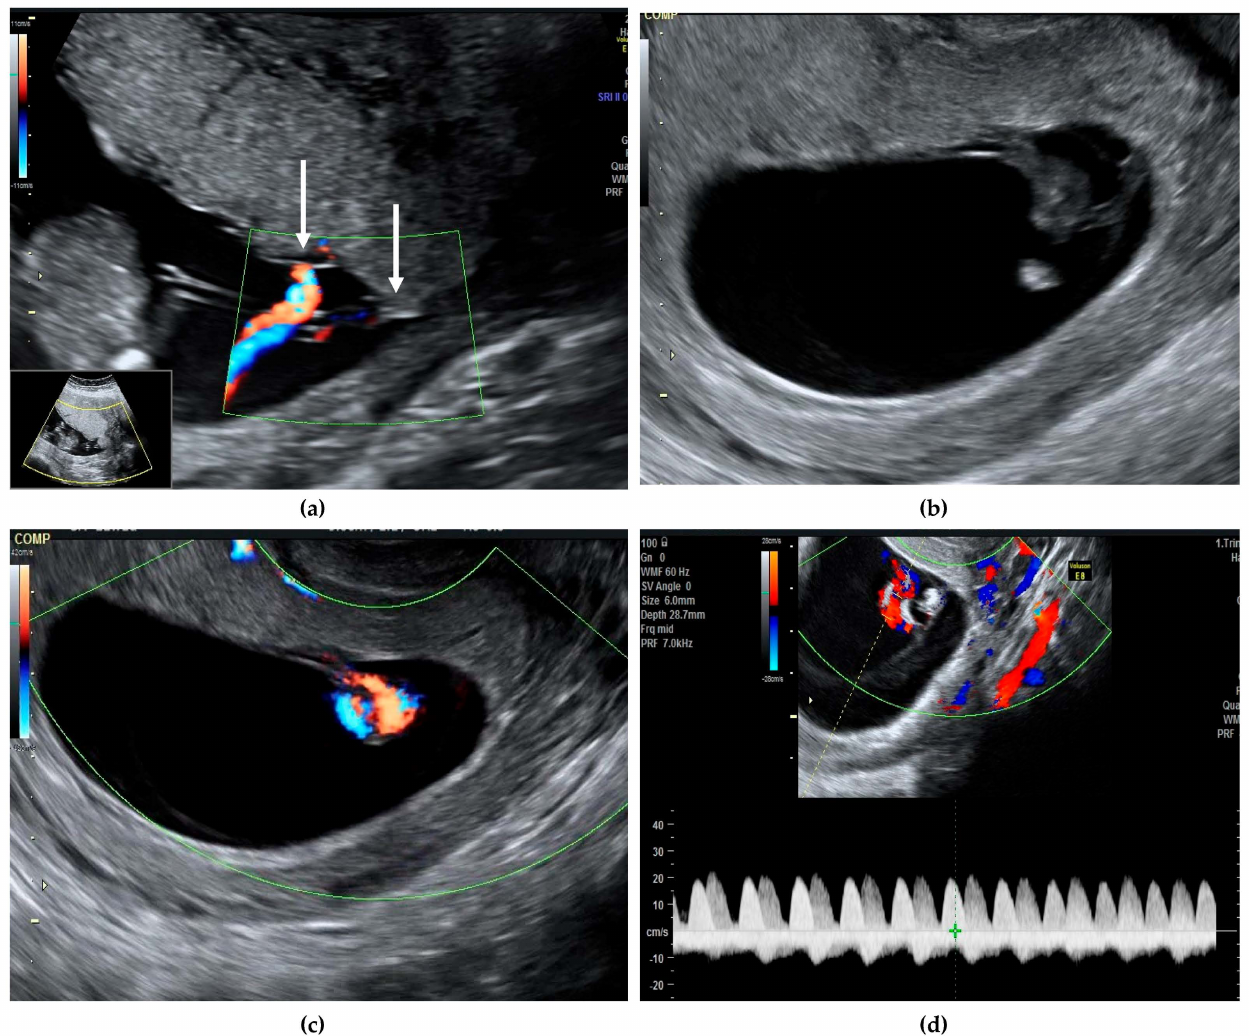
Figure 1. We present a case of a 30-year-old G2 P2 with a previous caesarean section, who presented in our unit at 11 weeks gestation for pregnancy confirmation after normal spontaneous conception. A viable monochorionic monoamniotic twin pregnancy was identified, and the common placenta and the cord insertions, very close to one another, were visualized ( a , white arrows). The second ultrasound evaluation at 13 weeks did not reveal any structural abnormalities and the risk for aneuploidies was low (Supplementary Materials). Cord entanglement was suspected at this early gestational age, both in gray scale and color Doppler ( b , c ). Simultaneous registrations of two different heart rates also suggested the cord entanglement ( d , represented by white and yellow arrows). The patient was counselled regarding the diagnosis, the possible complications, and the monitoring plan. The follow-up visit was planned for 16 weeks and both Doppler studies and growth were within normal ranges. From 16 weeks onwards, the follow-up scans were booked every second week. Unfortunately, the patient did not attend the 18 weeks scan, but she had a scan at 19 weeks. Sadly, double fetal demise was diagnosed. We acknowledge that this event was unpreventable and that routinely we recommend a scan every second week for reassurance. When fetal death occurs, this is an acute hemodynamic event, therefore previous scans are usually normal.